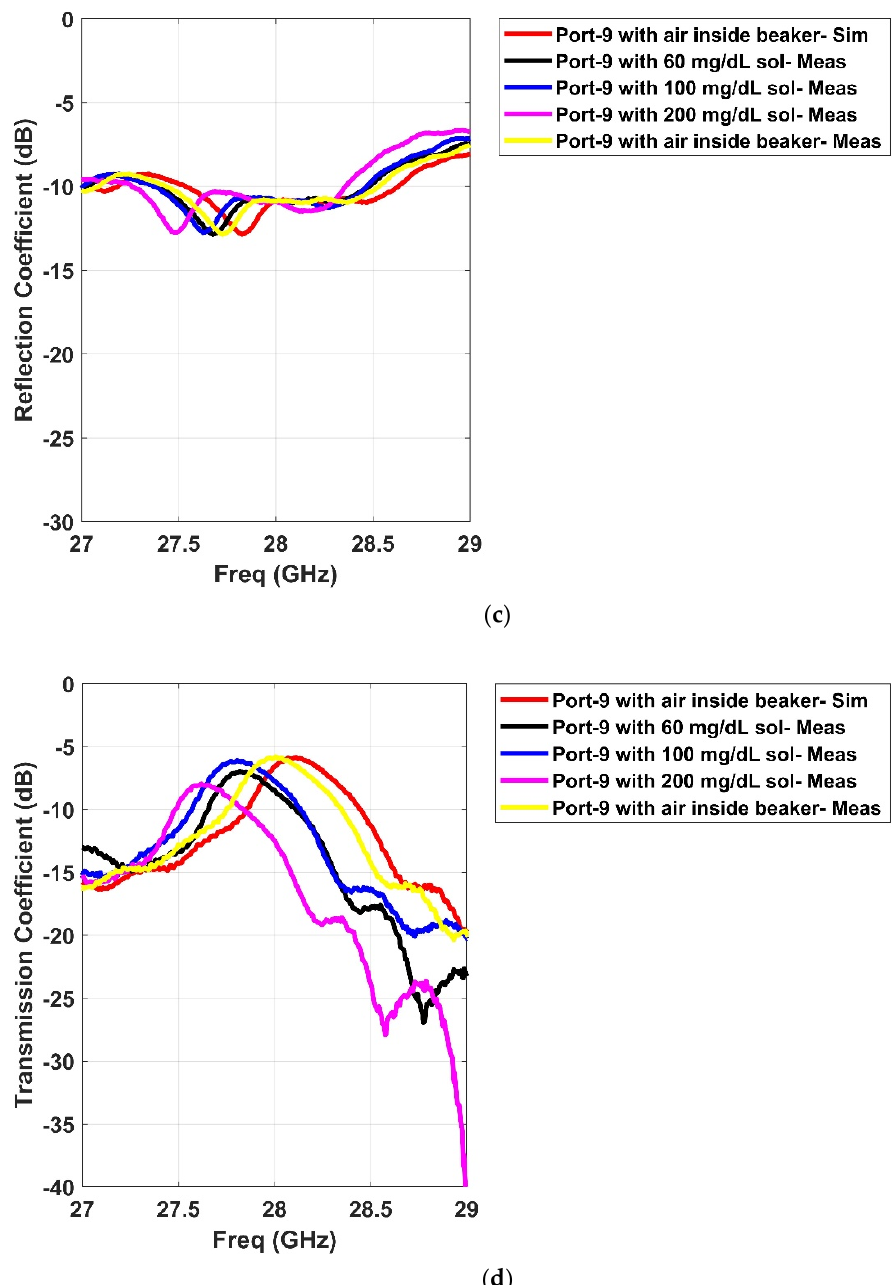
Figure 14. Comparison of simulated and measured responses of the proposed Rotman lens sensor after loading with prepared in-lab aqueous solutions: ( a ) Port 3 reflection coefficient; ( b ) Port 3 transmission coefficient between P39; ( c ) Port 9 reflection coefficient; ( d ) Port 9 transmission coeff- cient between P93.